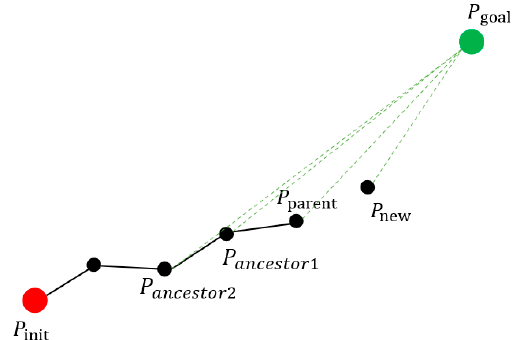
Figure 3. Random tree expansion diagram of the improved algorithm based on the RO strategy. The red circle indicates the starting point, and the green circle indicates the target point. The black circle indicates the path point, the solid black line indicates the path, and the green dashed line indicates the distance from the point to the target point. P ancestor 1 ~ P ancestor 2 denote the ancestor points, P parent denotes the parent point, and P new denotes the new